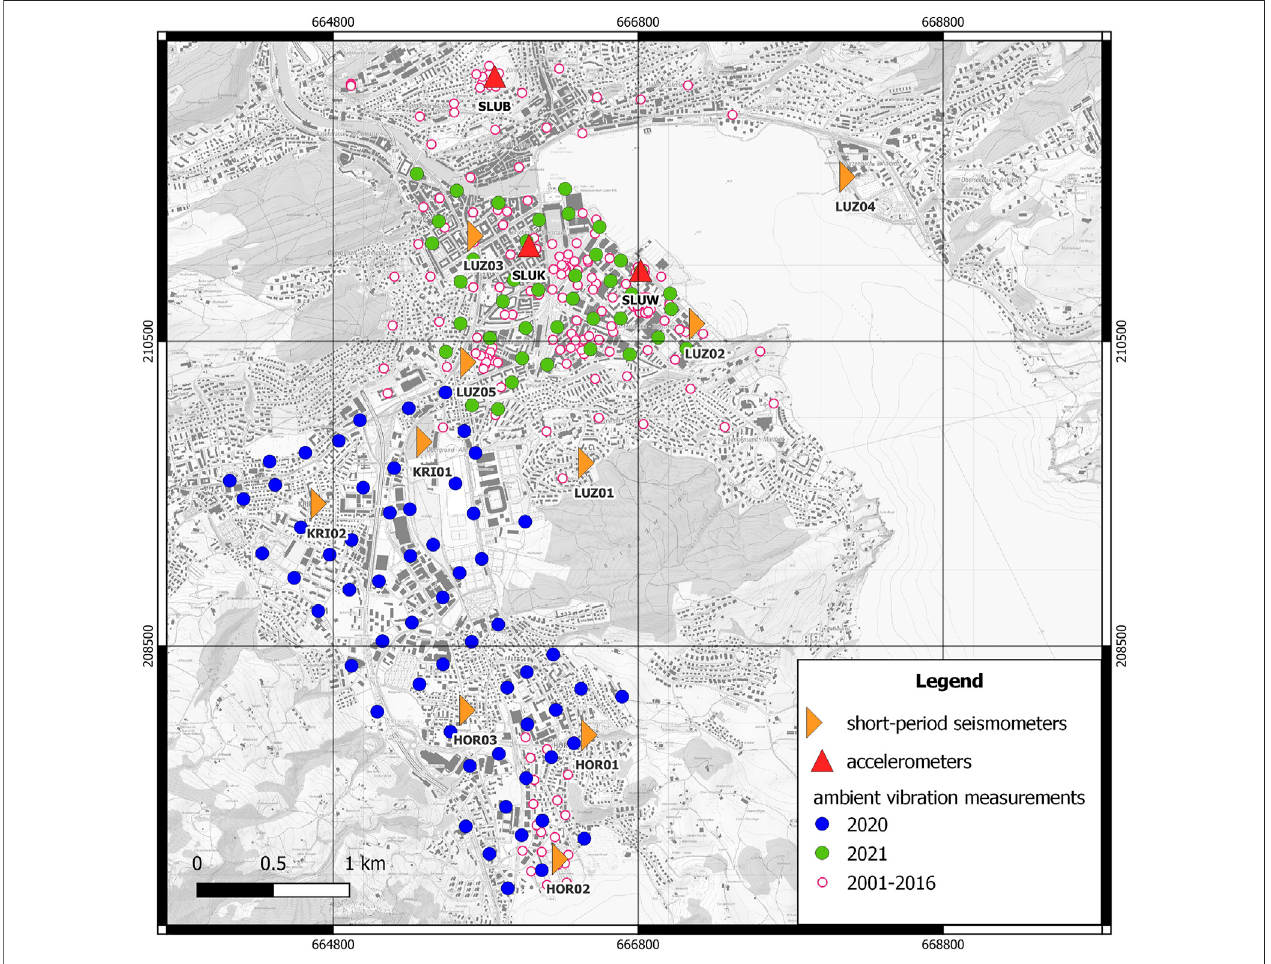
FIGURE 3 | Stations of seismic monitoring networks located in the Lucerne area and single-station ambient noise measurements. Short-period seismometers are part of the temporary local network, while accelerometers belong to SSMNet (Michel et al., 2014; Hobiger et al., 2021).